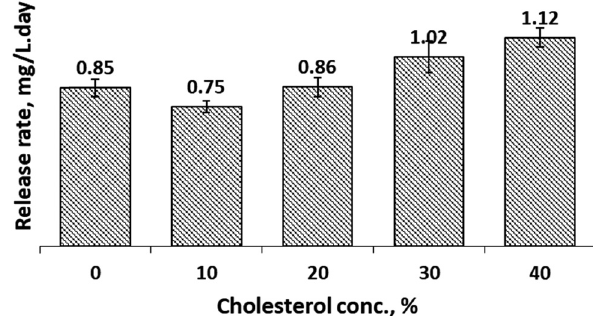
Figure 10: Release rate of Cur from cocoliposome in SGF solution as a function of cholesterol.